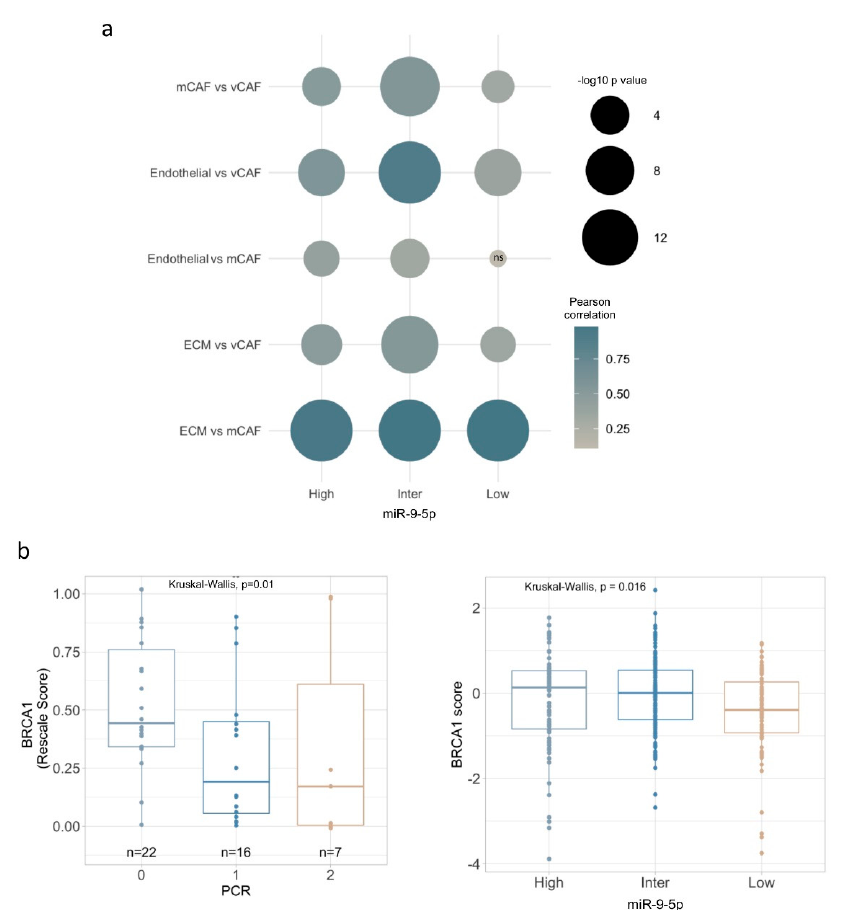
Figure 5. miR-9 expression in TNBC correlates with different CAF subsets and resistance to cisplatin. ( a ) Bubble plot showing computed Pearson correlations between TNBC subgroups according to miR-9 expression, CAF subsets and biological signatures of related functions. ns: non-significant, significant p value < 0.05. Bubble colour represents Person correlation, while size corresponds to -log10 p value, as illustrated in plot legend. ( b ) BRCA1 gene expression in two well-characterized cohorts of patients with TNBC treated in neoadjuvance with cisplatin (GSE18864 and GSE103668), evaluated Pathological complete response by Miller-Payne (MP) criteria (0: MP 0, 1, 2 Progression, no change or still high tumor cellularity; 1: MP 3, 4 minor and marked loss of tumor cells, 2: MP 5 non-malignant cells) (left panel), and BRCA1 gene expression in TNBC sub-grouped by miR-9 expression (right panel).